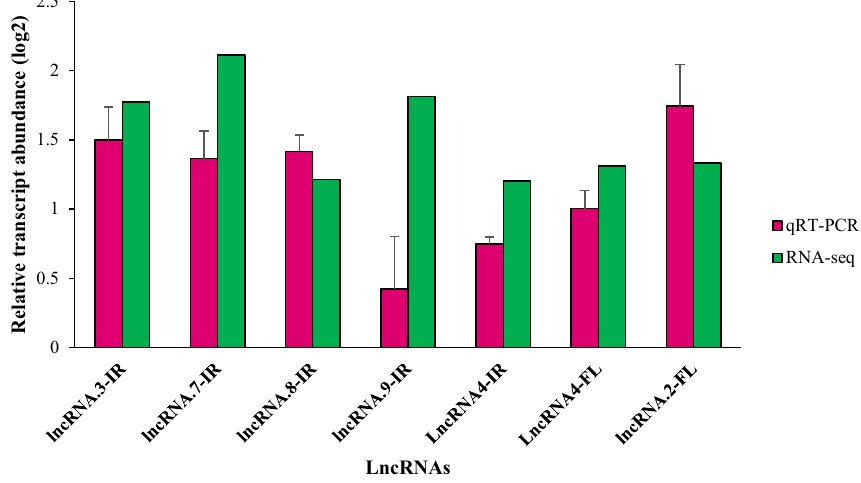
Figure 7. Validation of DE-lncRNAs using qRT-PCR in root tissues of FL478 (tolerant genotype) and IR29 (sensitive genotype). Bar graphs represent the relative transcript abundance of DE-lncRNAs based on three biological replicates, the standard deviation of the relative expression levels (n = 3) is indicated by error